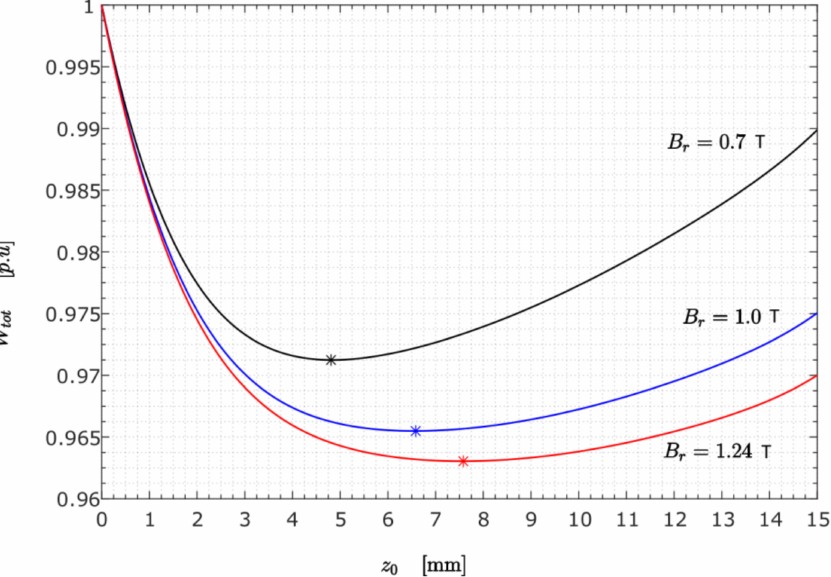
Figure 19. The PM’s equilibrium height calculated by EM. The results are shown for three different values of the PM’s remanence, i.e., B r = 0.7 T, B r = 1.0 T, and B r = 1.24 T, respectively. The minimum value on the individual curve is indicated with the Asterisk (*). Each of the curves were normalized by its maximum